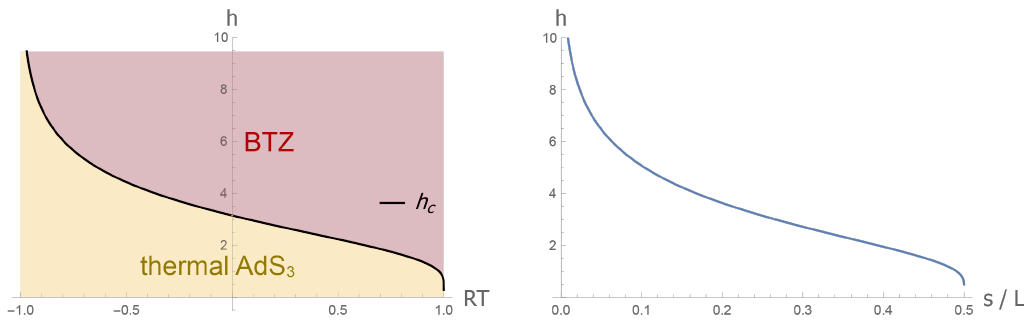
Figure 8 . Left: phase diagram for the BTZ/thermal AdS 3 (connected/disconnected) phase transition. The critical value of h is diverging for negative critical tension, it vanishes for positive critical tension and takes the value h = π in the tensionless case. Right: h , defined in equation (2.9), c is a monotonically decreasing function of the size s of the measured regions A exactly half of the CFT is measured (i.e. s/L = 1 / 4 ), h = π . In the tensionless case, this is also the (Hawking-Page) critical